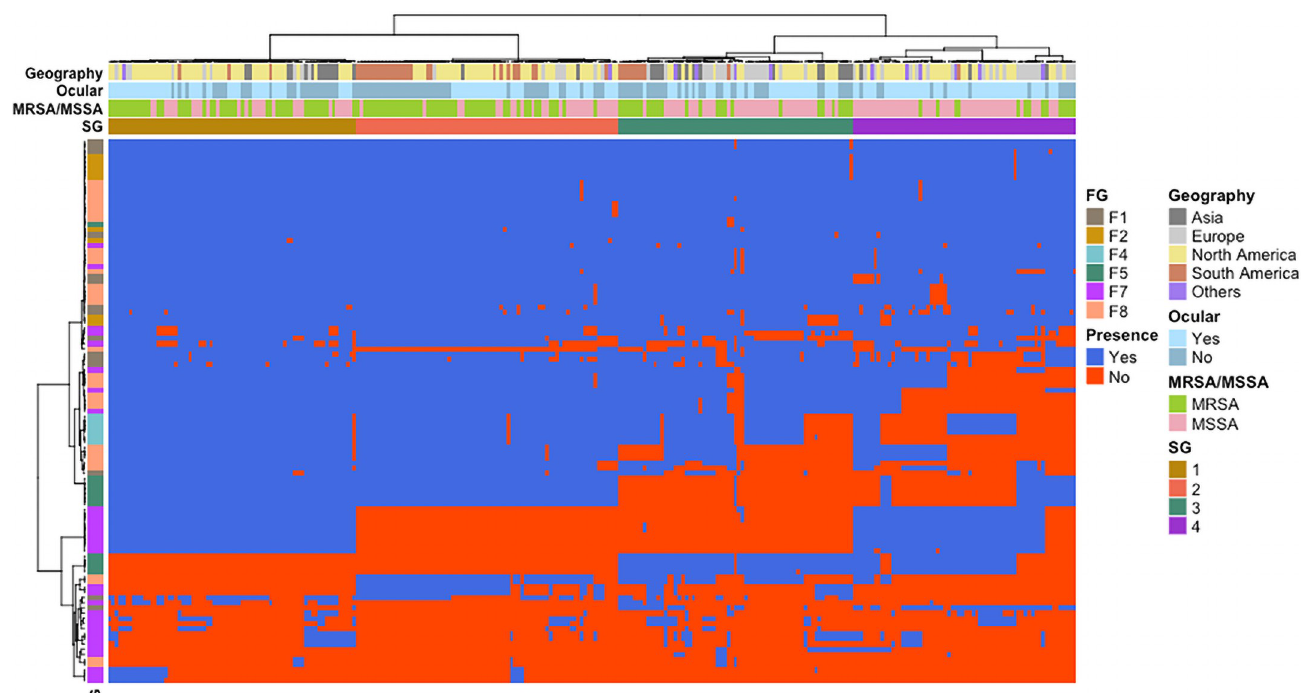
Fig 4. Heatmap plot demonstrating the pattern of virulence factor distribution across both ocular and non-ocular isolates. Using a Ward’s minimum variance method, the phylogenetic tree across the top was created based on the presence/absence of 235 known S . aureus virulence factors, while the tree on the left-hand side is a representation of virulence factor similarity. The geographical origin of the isolates, MRSA/MSSA status as well as ocular vs non-ocular designation is represented in rows. Conversely, columns represent individual virulence factors with functional groups (FG): F1—Adherence; F2—Cytotoxin/ hemolysin; F4—Protease inhibitor; F5—Capsular polysaccharide; F7—Immune modulator; F8—Toxin.